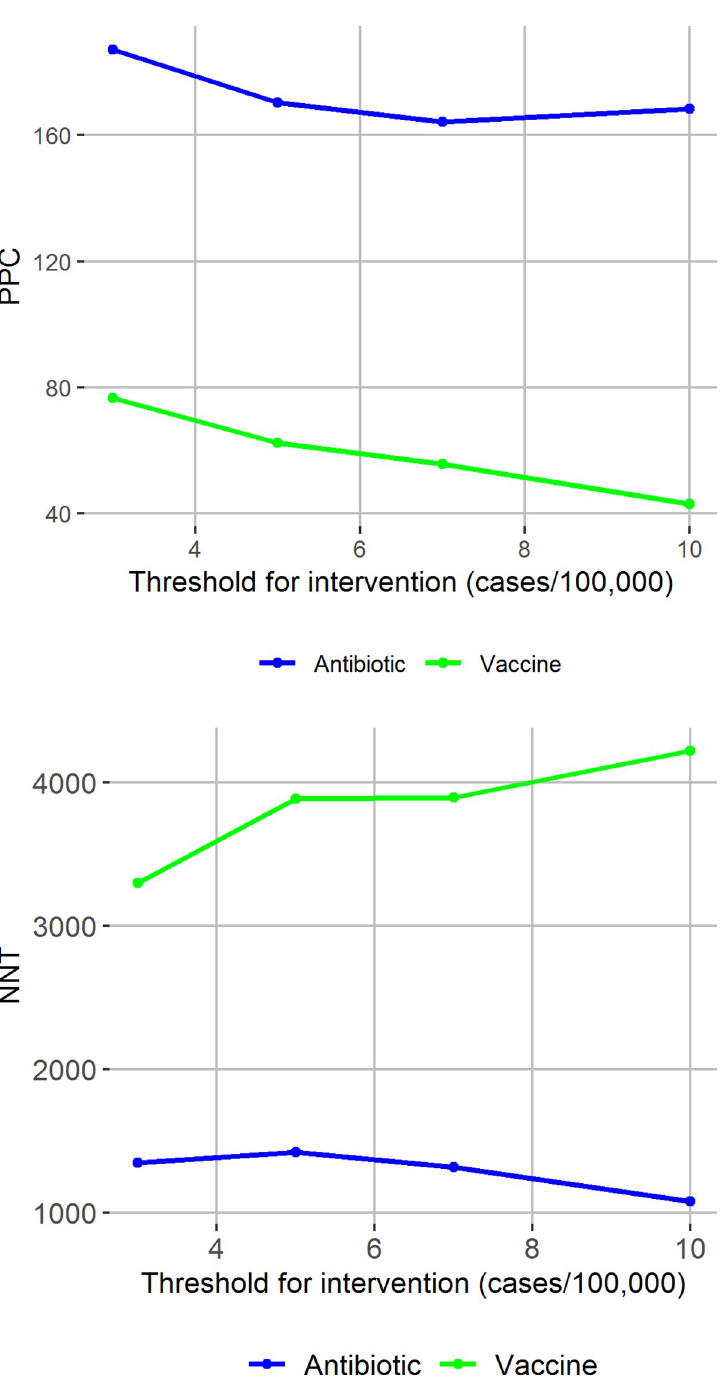
Fig 5. Potentially effectiveness and efficiency of village-antibiotic and village-vaccination prophylaxis strategies. Potentially prevented cases (PPC) and number needed to treat/vaccinate per PPC from applying a village-prophylaxis antibiotic (blue) and vaccination (green) strategy, varying the threshold for intervention at the health area